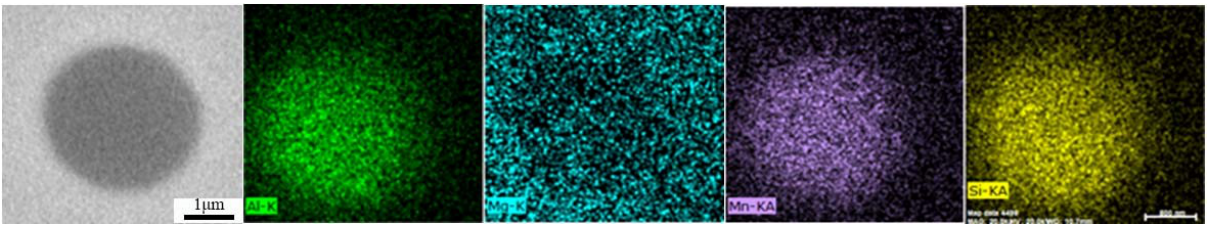
Figure 8: The elemental mapping of typical inclusion in steel when the time of 40min (Al 2 O 3 -SiO 2 -MnO)